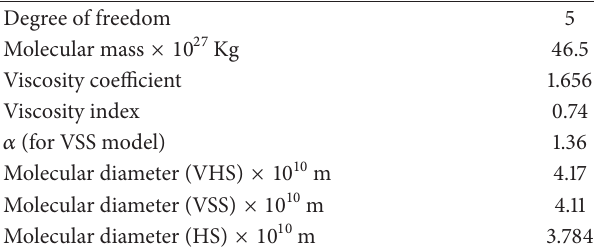
Table 2: Properties of nitrogen molecule in DSMC.